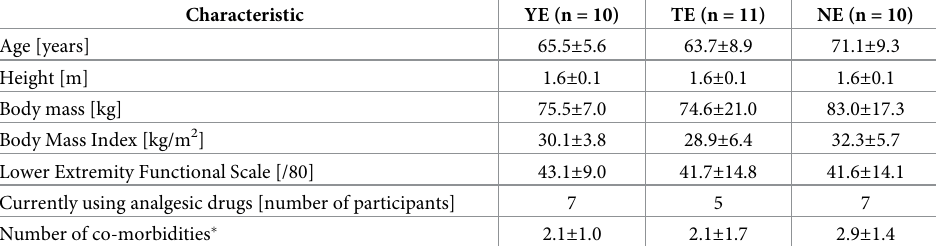
Table 1. Baseline clinical characteristics (expressed as mean ± standard deviation) of yoga exercise (YE), tradi- tional exercise (TE), and no exercise (NE) groups. The number of participants that self-reported using analgesic drugs is denoted for each group.